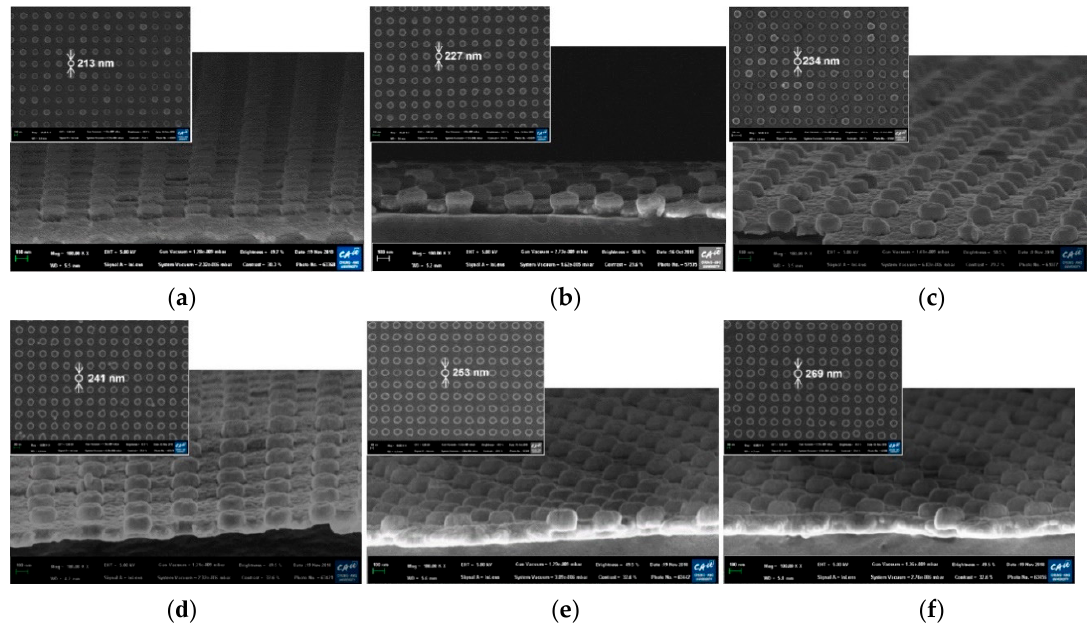
Figure 3. Cross-sectional SEM images of the fabricated PNAA MEF substrates with Ag thicknesses of ( a ) 25 nm, ( b ) 50 nm, ( c ) 75 nm, ( d ) 100, ( e ) 125, and ( f ) 150 nm. The insets show the corresponding top-view SEM images. Enlarged cross-sectional SEM images of Figure 3a–d are included in the Supplementary Materials.